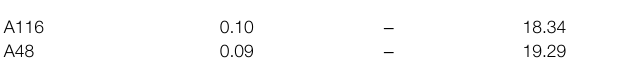
TABLE 3 | The correlation between the biofilm biomass of 62 A. baumannii and their mRNA levels of BIT33_RS14560